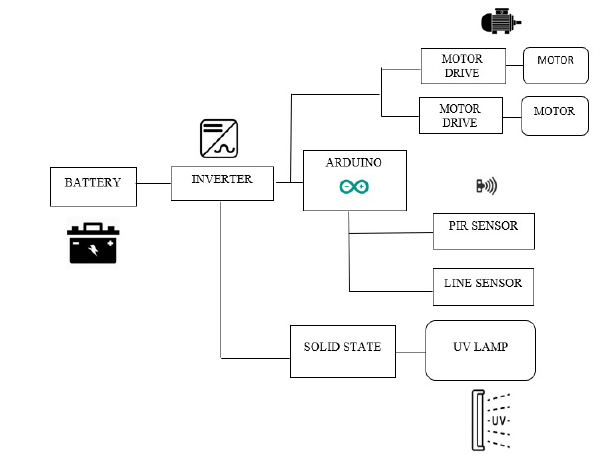
Figure 5. Block Diagram of Controlling System